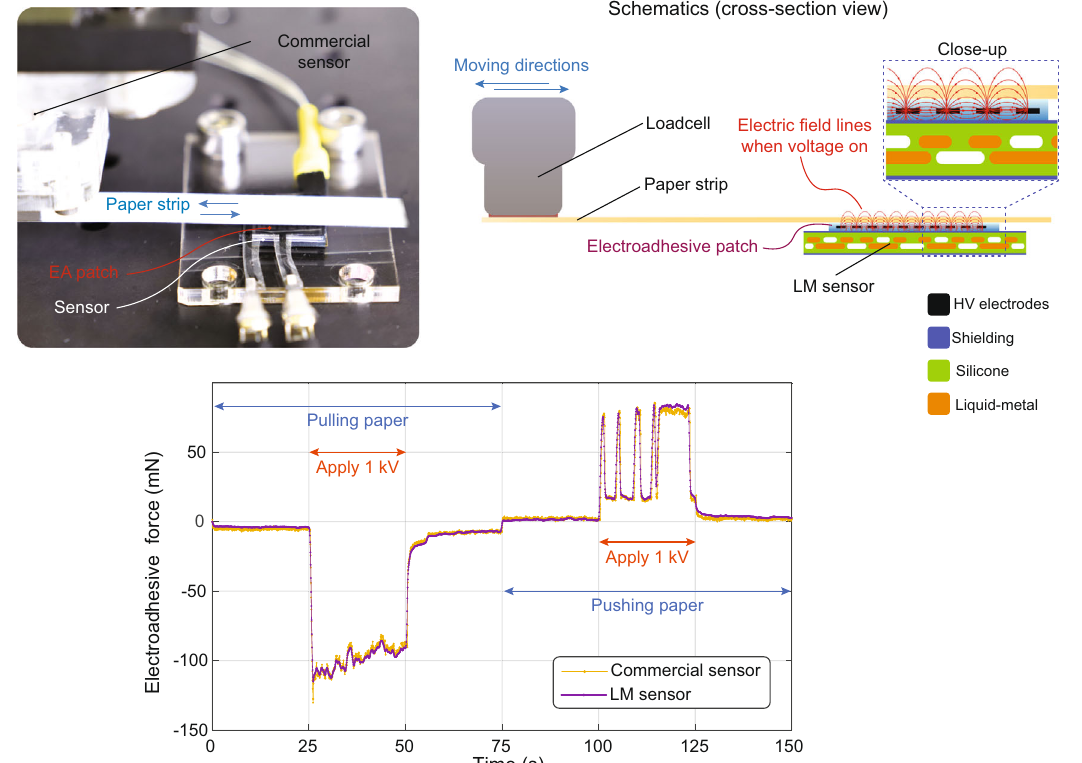
Fig. 8 | The soft sensors accurately measure the traction force between the paper strip and electroadhesive surface. The photographs show the experi- mentalsetupandtheclose-upoftheelectroadhesivepatch(EA),whichoperatedat 1kV AC during pulling and pushing tests. The EA patch is directly placed on top of thesensor.Thevoltageisturnedonbetween25and50s(pulling)andbetween100